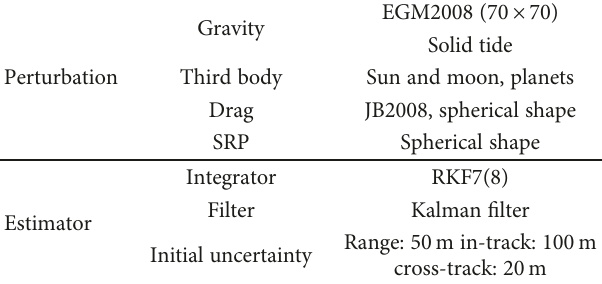
Table 3: Orbit estimator setup and used perturbations.